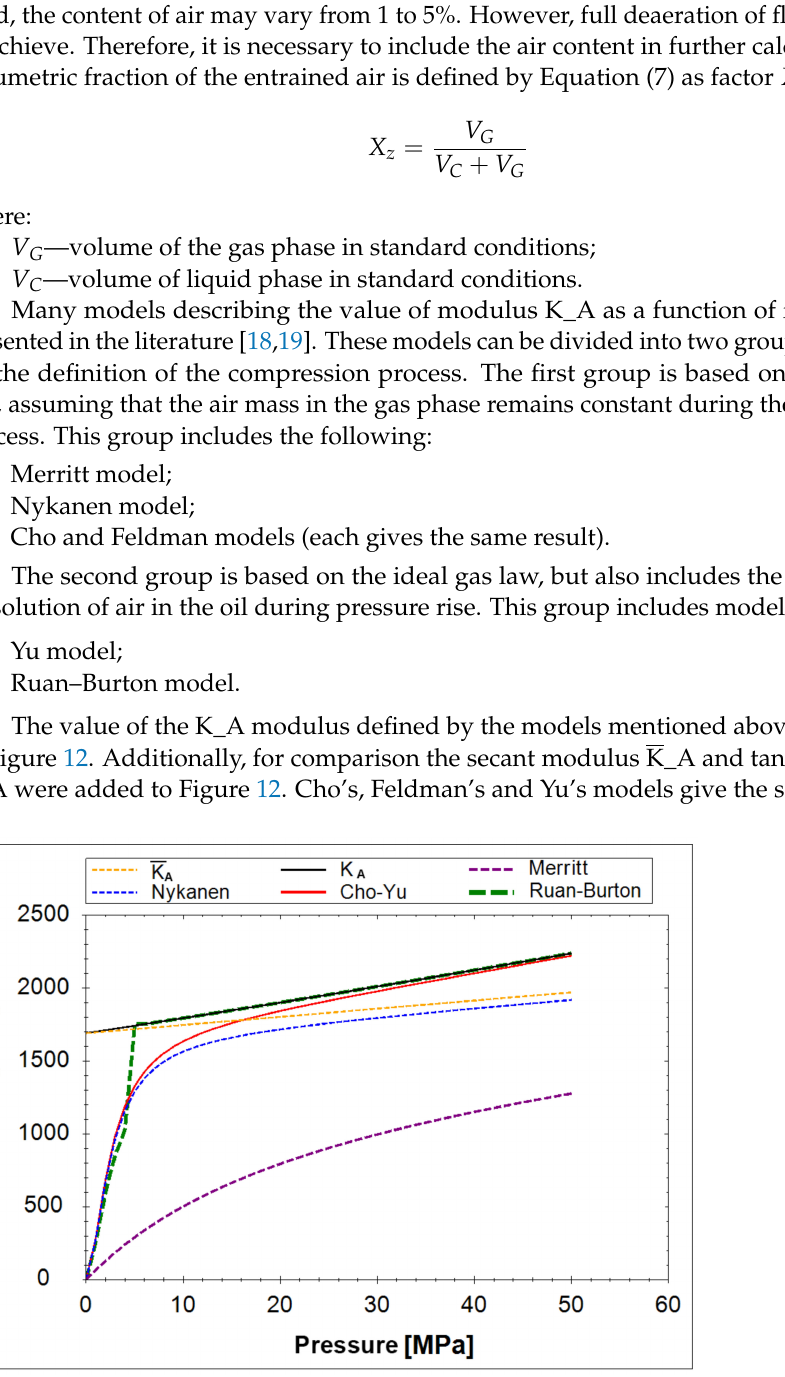
Figure 12. Comparison of the bulk modulus models for Total Azolla ZS 46